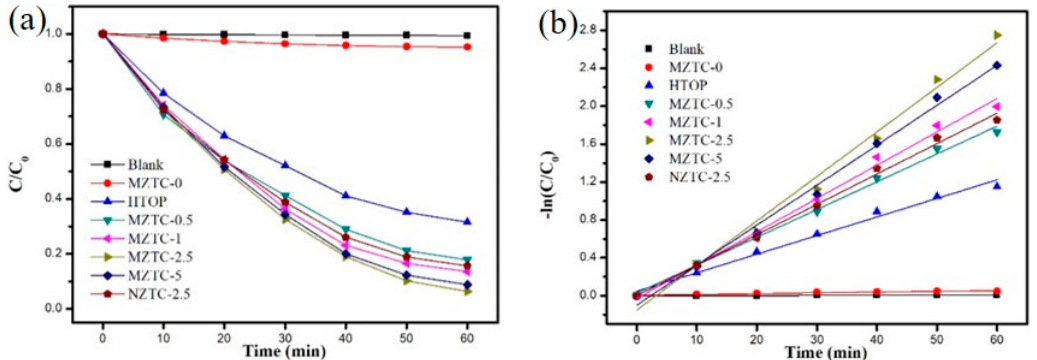
Figure 7. ( a ) The MB degradation rate of different samples within 60 min; ( b ) The corresponding linear fitting curves using the first-order reaction kinetics model. Table 2. The parameters of the photocatalytic degradation reactions. (k = reaction rate constant; R 2 = 201